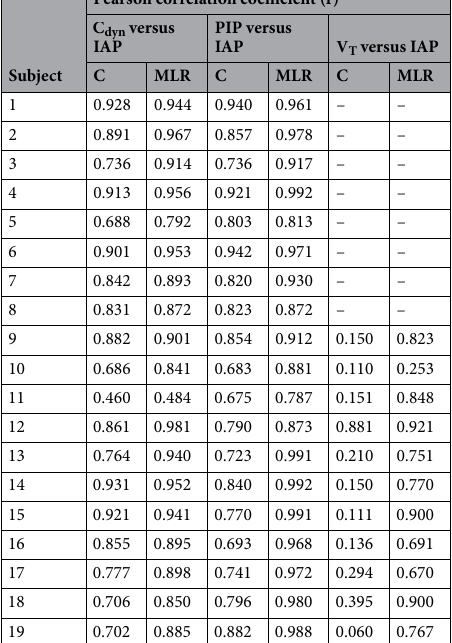
Table 1. Pearson’s correlation coefficients (r) between the IAP and lung mechanics values for all subjects. C is the linear regression correlation between the IAP and the PIP , the C dyn and the V T . MLR is the multiple/ multivariate linear regression correlation after including ventilation